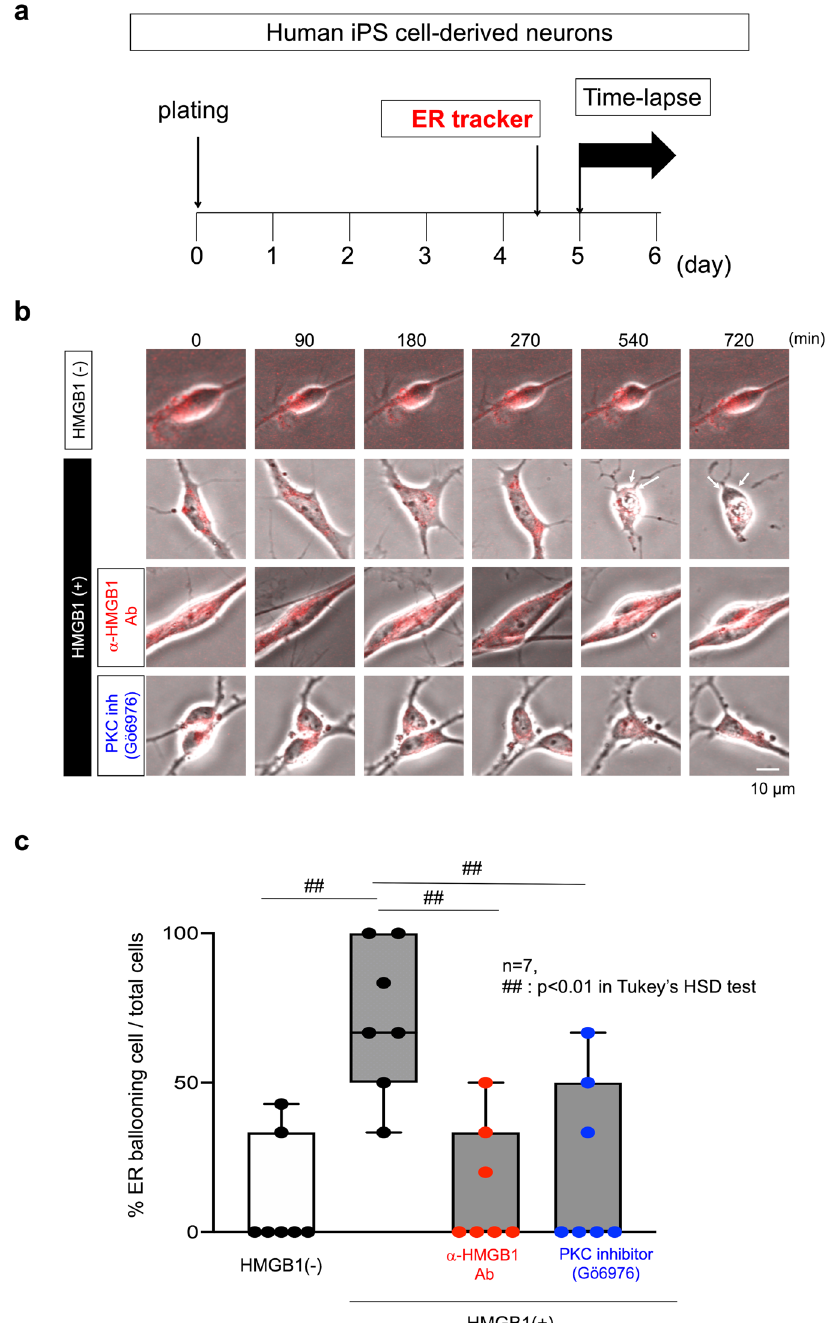
Fig. 7 HMGB1-induced TRIAD necrosis of iPSC-derived neurons and the suppression by human monoclonal anti-HMGB1 antibody. a Time-lapse imaging protocol used in b and c . HMGB1 antibody or PKC inhibitor was added to the medium of iPSC-derived neuron simultaneously with HMGB1. b , c Time-lapse imaging of normal iPSC-derived neurons. Addition of HMGB1 increased ER ballooning, which was suppressed by the HMGB1 antibody or PKC inhibitor. Box plots show the median, quartiles, and whiskers that represent data outside the 25th to 75th percentile differentiated neurons 68 . Mutations of cilia-associated genes in human patients produce a variety of phenotypes including microcephaly, cerebellar hypoplasia, and cognitive impairment 69 . In addition to the role of neuronal primary cilia in the development of the brain and neural network 68 – 70 , postnatal ablation of cilia in adult neurogenesis impairs learning and memory in adulthood 71 , although knowledge of the roles of neuronal primary cilia in neurodegeneration is limited 72,73 . Therefore, human iPSC neurons were stained and their frequency